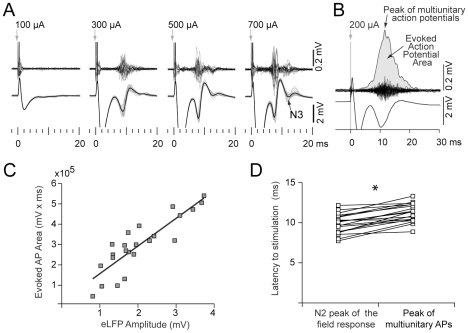
Evoked field response precedes the peak of multiunitary action potential response.
A. Field (3–300 Hz) and action potential (300–3000 Hz) responses at the hot spot to increasing stimulation current intensities. Note the secondary field response (N3 peak, black arrow) at high stimulation intensities (20 trials at each intensity). B. To quantify the action potential response, trials were rectified, smoothed and averaged, allowing the computation of the area and peak latency of the multiunitary action potential response. C. Correlation between the amplitude of the evoked field potential and the area of the action potentials response at 300 µA; each point stems from one recording site at the hot spot from 23 different experiments. r2 = 0.84, p<0.0001. D. Field response N2 peak precedes the peak of multiunitary action potential response (n = 23, * p<0.005, Student's paired t test).